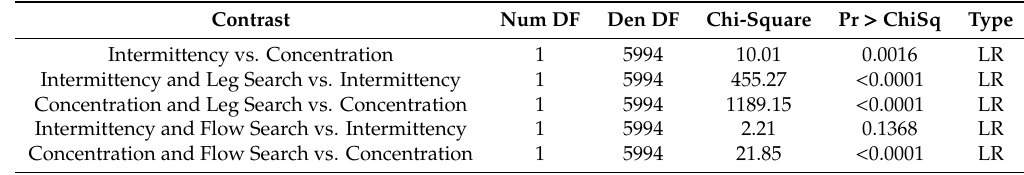
Table 3. Generalized linear model contrast results for various search algorithms based upon lobster antennules, leg chemosensors, and mechanosensors. Num DF is degrees of freedom in the model, Den DF is the number of degrees of freedom from model error. Pr > ChiSiq is the probability that the observed Chi-Square value is observed if the null hypothesis that the search strategies are the same is true. Type of model used is Likelihood Ratio (LR).